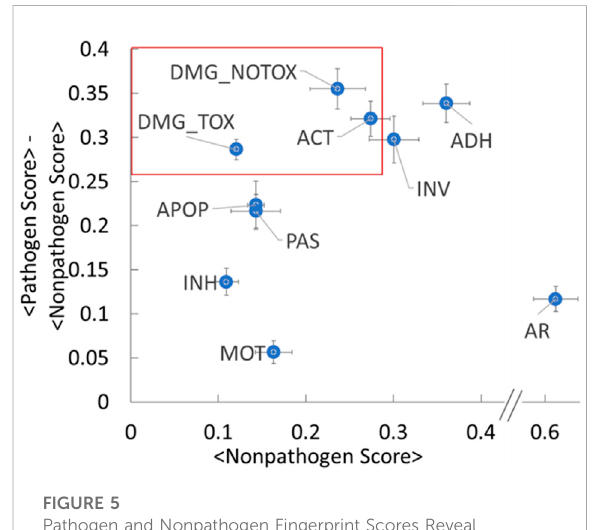
FIGURE 5 Pathogen and Nonpathogen Fingerprint Scores Reveal Strati fi cation Among Functional Hazard Categories. The plot shows a difference in average scores between the pathogens and nonpathogens ( y -axis) as a function of the average nonpathogen score ( x -axis) for the functional categories from the heat plots in Figure 3. The error bars represent the standard error. The abbreviations are the same as Figure